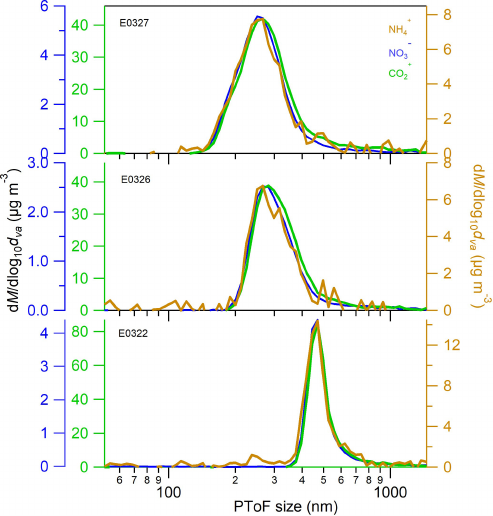
Figure 4. The averaged 30min size distribution of organic acids (represented by CO + ion measured by AMS), nitrate and ammo- 2 nium in the last 30min prior to the end of the nucleated SOA exper-